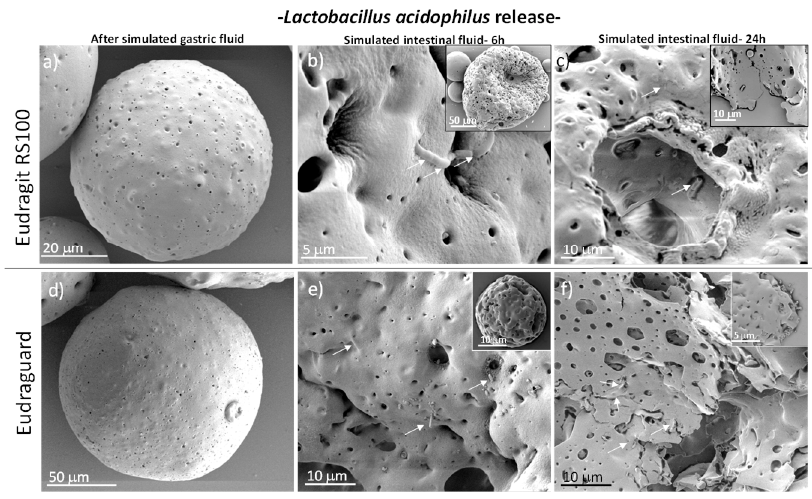
Figure 7. SEM micrographs of Eudragit RS 100 ( a – c ) and Eudraguard ( d – f ) microparticles loaded with Lactobacillus acidophilus and immersed in simulated gastric ( a , d ) and intestinal fluids ( b , c , e , f ). White arrows depict the location of bacteria.